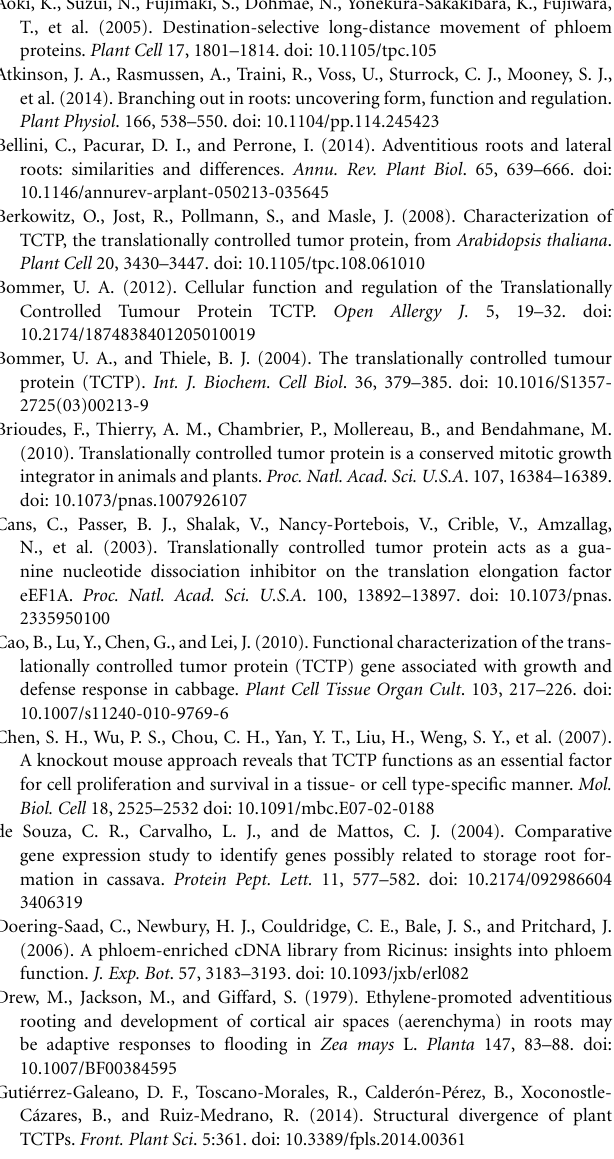
Figure S1 | AtTCTP2 and NtTCTP nucleotide and amino acid alignments. Divergent nucleotide and amino acid regions between these two sequences are shown ( A and B , respectively). Figure S2 | Comparison of NtTCTP transcript levels between transgenic and WT stocks or scions. Using the same total RNA extracted previously from stocks or scions, samples were homogenized to a given concentration (100ng/ µ l) to be used as templates. (A) Specific primers were used to detect a unique sequence for NtTCTP ORF that does not amplify any region within the AtTCTP2 ORF to detect the levels of NtTCTP mRNA. (B) qRT PCR was performed and arbitrary fluorescence units detected for NtTCTP in transgenic (AtTCTP2-GFP) stocks or scions (blue bars) were compared to their WT counterparts (green bars) in grafts after being normalized against 18S as reference. At least three biological and technical replicates were performed in each case, given as means ±